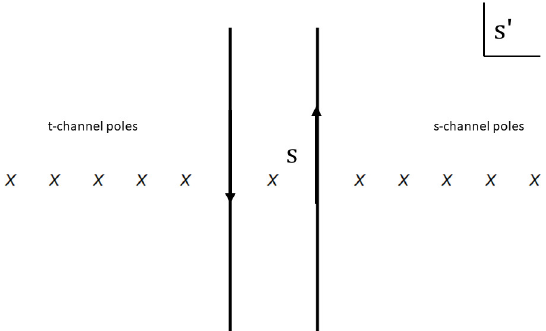
Figure 1 . Mellin contours for M s t -channel poles are located at s 0 = s + t − τ − 2 m for m ∈ Z